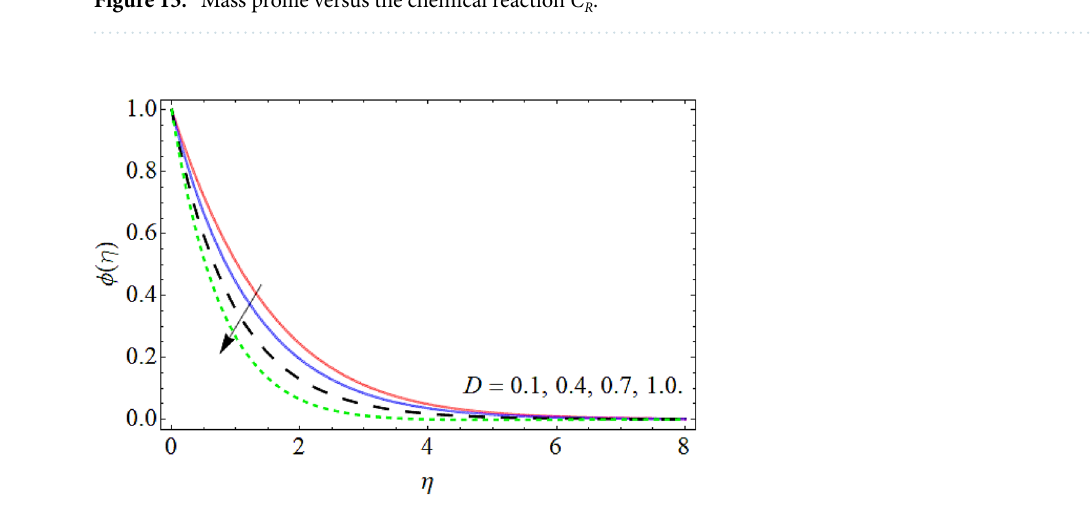
Figure 16. Mass profile versus the Deborah number D